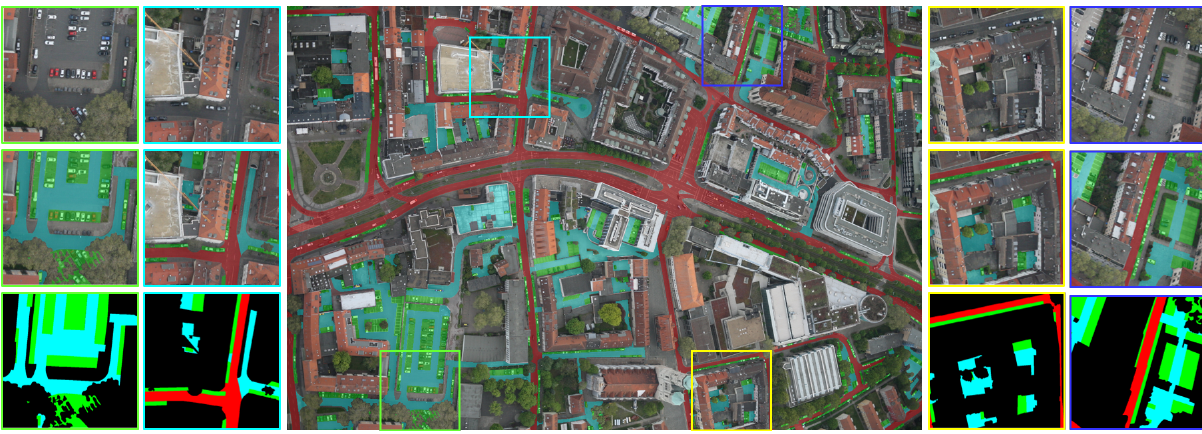
Figure 3. Zoomed-in samples of aerial images, annotations and overlay from our dataset with the three classes: ∎∎∎∎∎∎∎∎∎∎∎∎∎∎∎∎∎ parking area, ∎∎∎∎∎∎∎∎∎∎∎∎∎∎∎∎∎ road and ∎∎∎∎∎∎∎∎∎∎∎∎∎∎∎∎∎ access way.